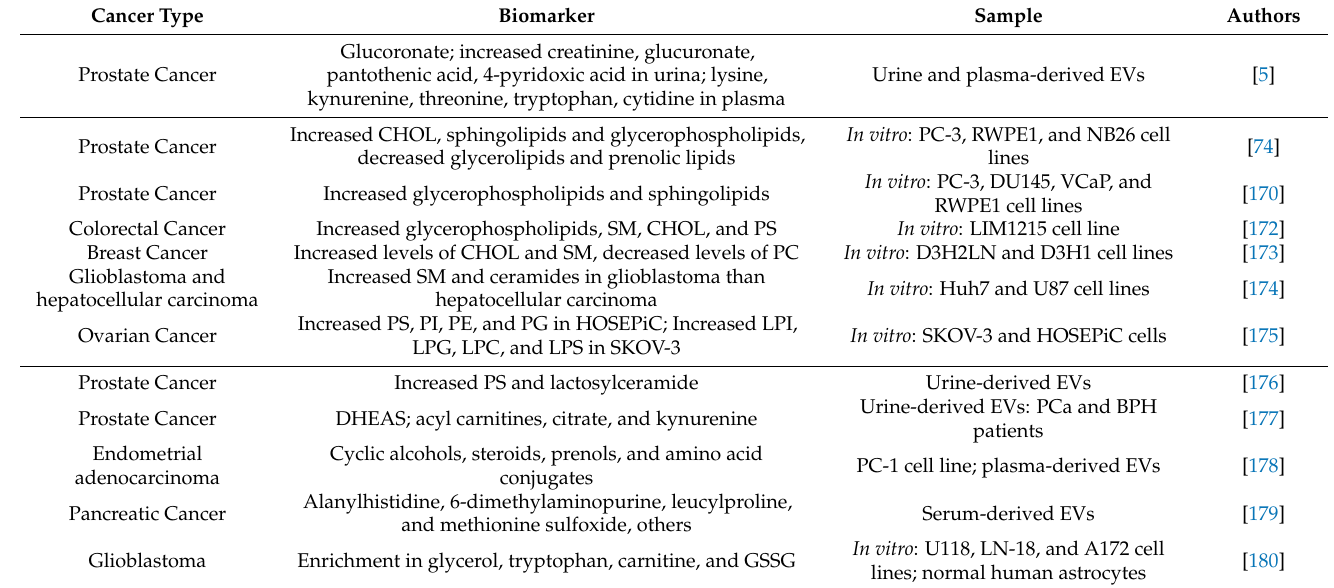
Table 2. Summary of the lipids and other metabolites identified in EVs with potential as biomarkers of different cancers. Cancer